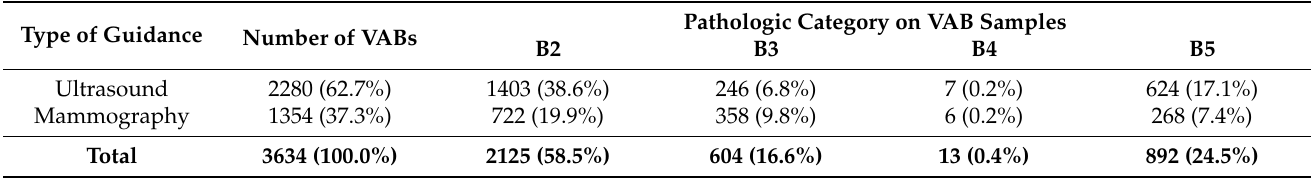
Table 1. Vacuum-assisted biopsies performed from January 2011 to June 2018.